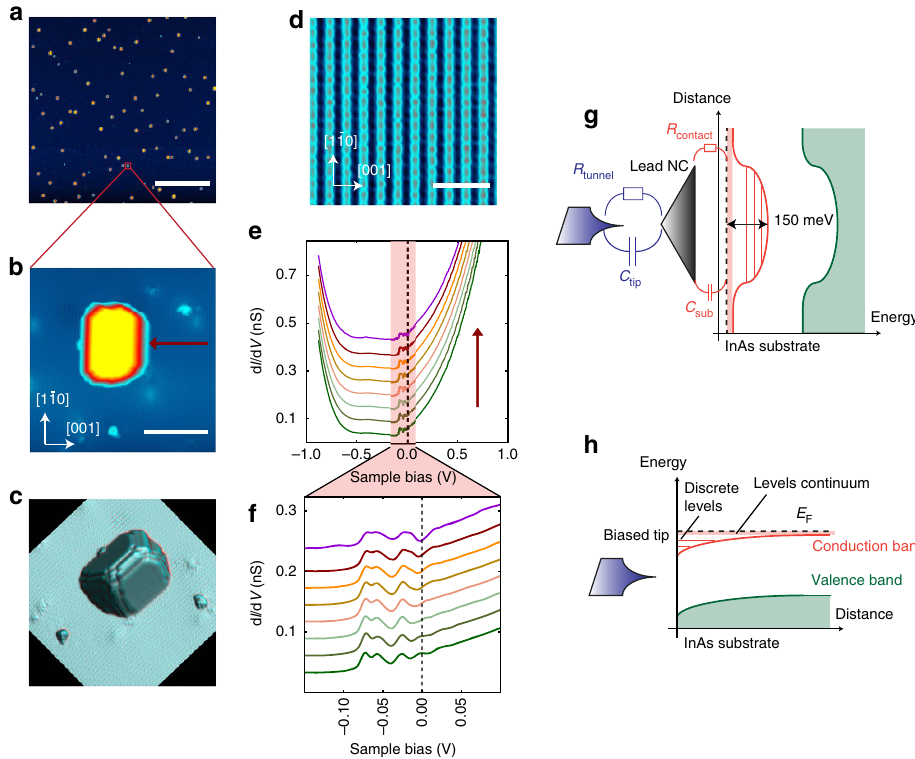
Figure 1 | Pb NCs on InAs (110). ( a ) 1 m m (cid:3) 1 m m topographic STM image (1V, 30pA) of Pb NCs grown on the (110) InAs surface of sample A. Scale bar, 300nm. ( b ) Zoom on 30nm (cid:3) 30nm area, showing a Pb NC. Scale bar, 10nm. ( c ) 3D Laplacian D x y z ( x , y ) image of a NC. ( d ) 6.5nm (cid:3) 6.5nm atomic resolution image of InAs (110) obtained near the NC. Scale bar, 2nm. ( e ) DC measured at several distances from the Pb NC along the red arrow in b . ( f ) Zoom at low bias showing the conductance peaks due the discrete levels of the tip-induced quantum dot. ( g ) Sketch of the band bending below the Pb NC due to the pinning of the Fermi level at the charge neutrality level. ( h ) Sketch of the band bending induced by the tip leading to the formation of a quantum